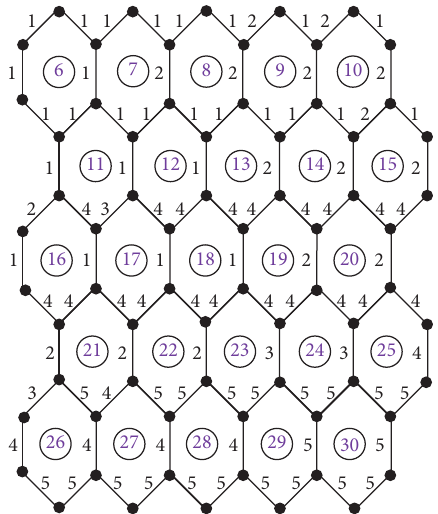
Figure 2: Labeling and weights of hexagonal grid graph H 6